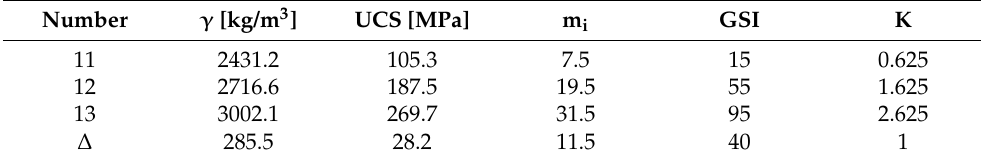
Table 5. Additional values of the five parameters to generate new test